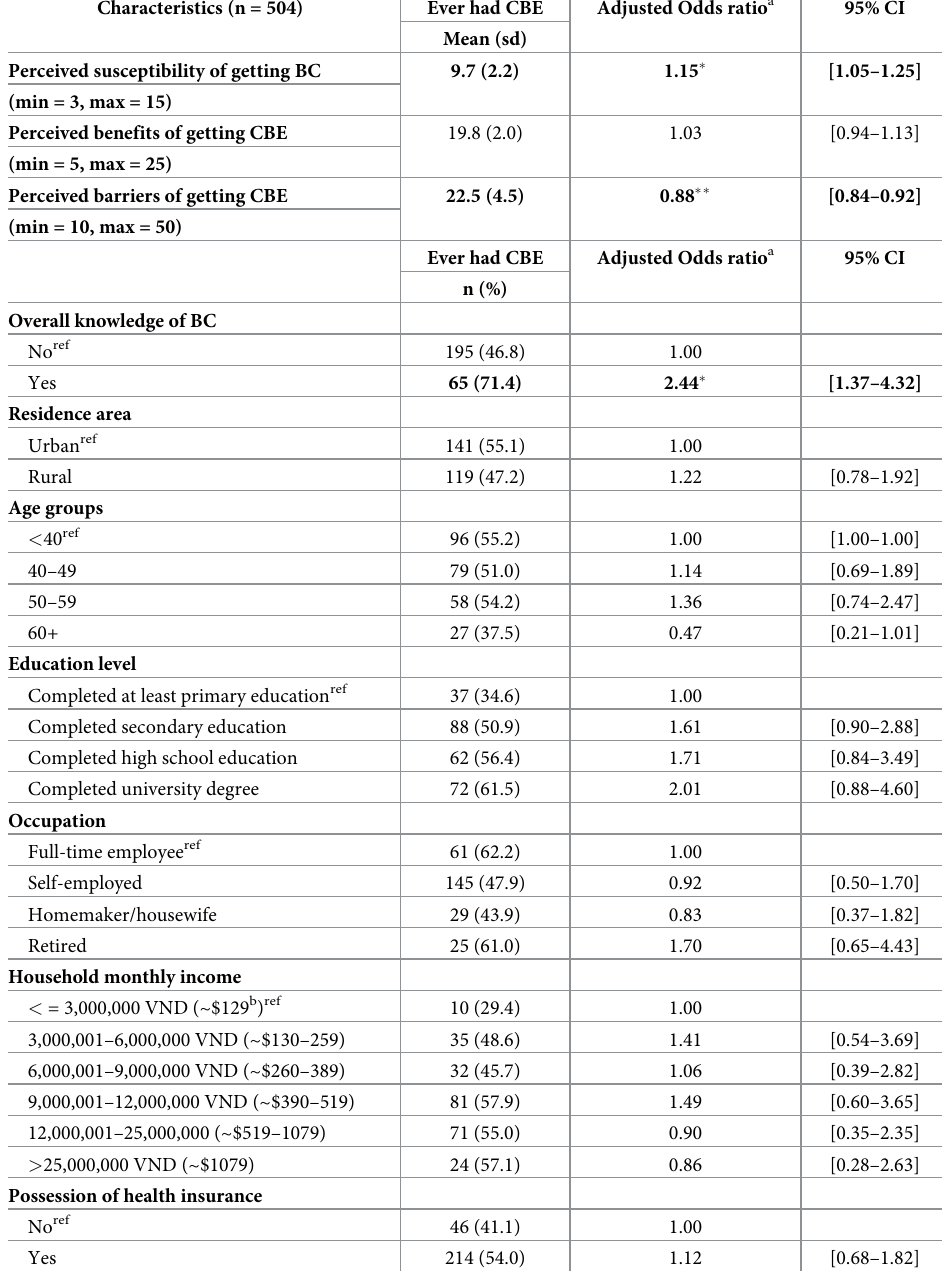
Table 4. Which factors are associated with the uptake of clinical breast